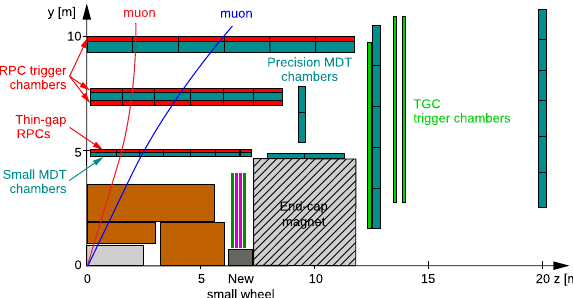
Fig. 1 One quadrant of the ATLAS muon spectrometer after the upgrades which will add new thin-gap RPCs and MDTs in the inner barrel region. The z -axis points along the beam direction and the colli- sion point is at the origin